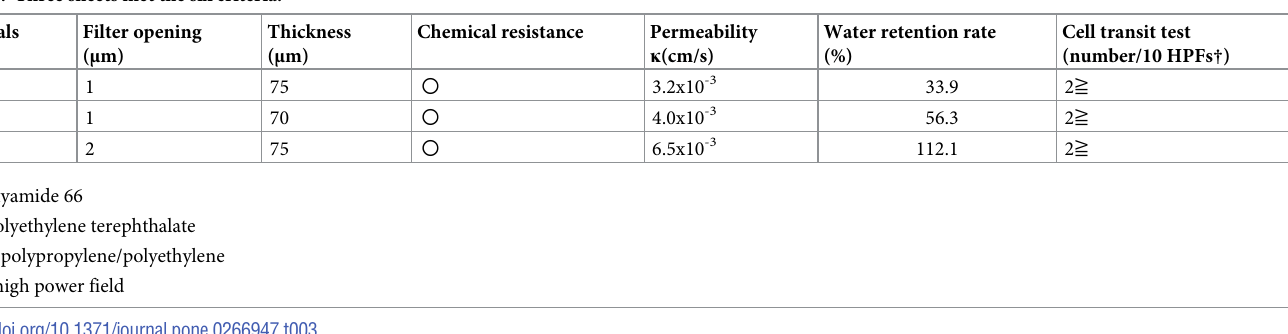
Table 3. Three sheets met the six